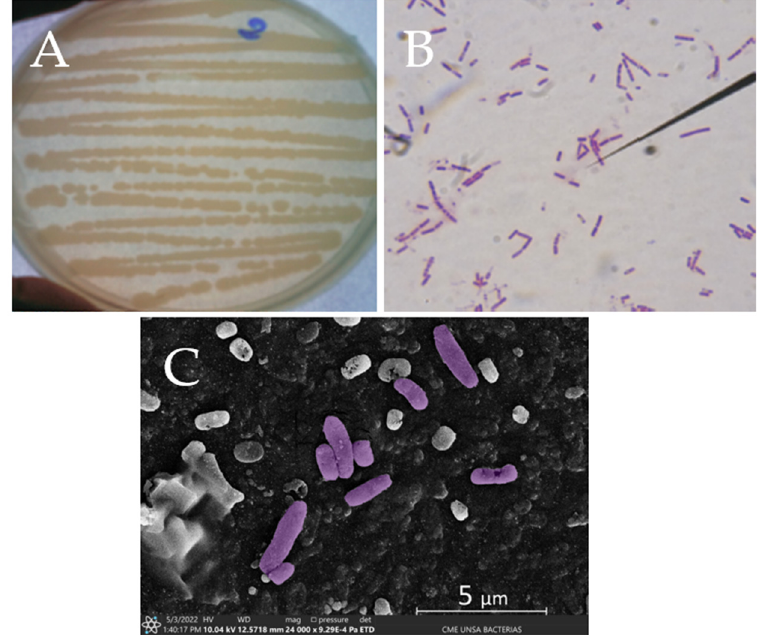
Figure 4. Morphological characterization of the Av_G1 strain: ( A ) isolation of bacteria by LB agar after 24 h, ( B ) observation of the final replicate of the Av_G1 strain under an optical microscope and Gram-negative staining. ( C ) Citrobacter sp. Av_G1 from the biofilm under electron microscopy with 24,000× magnification with a reference of 5 µm in size and coloration of the strain to distinguish the microorganism.